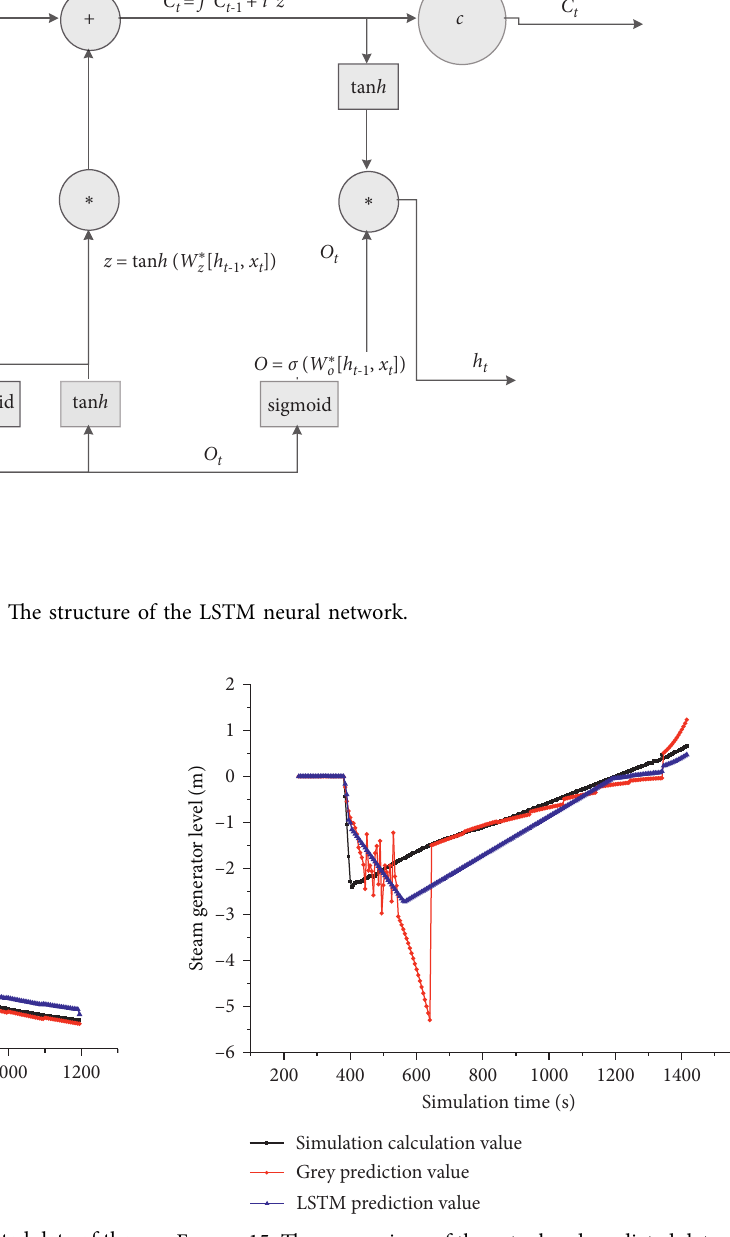
Figure 15: The comparison of the actual and predicted data of the steam generator water